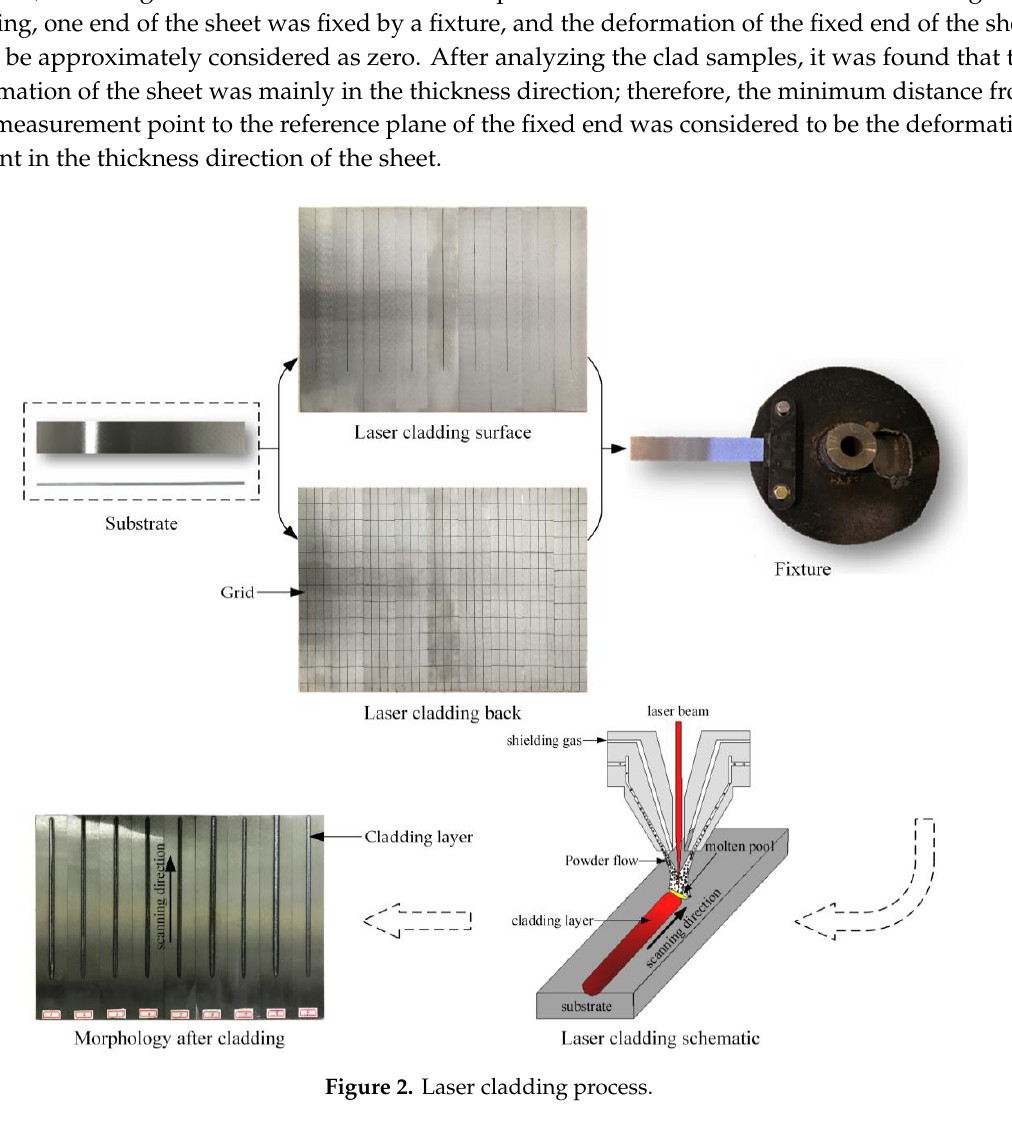
Table 4. Orthogonal experiment scheme.